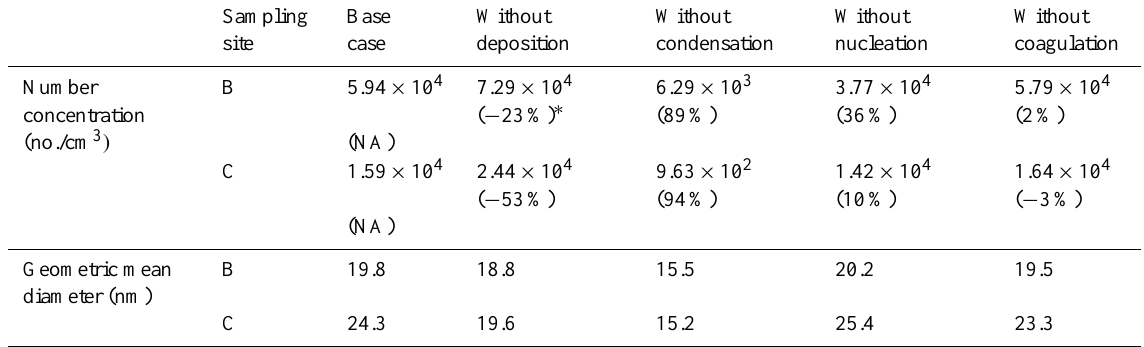
Table 6. Number concentration and mean diameter of the nucleation mode particles predicted by the model under different scenarios.